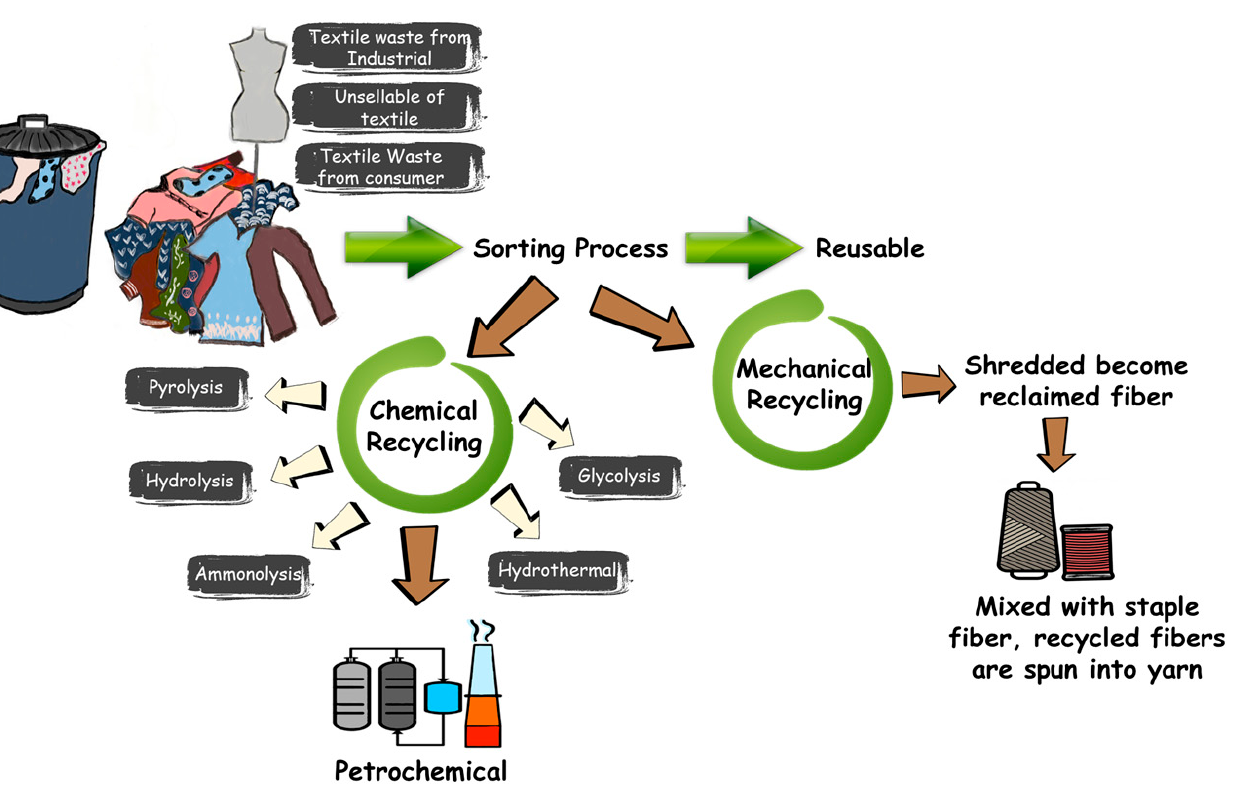
Figure 3. Mechanisms of possible textile waste recycling